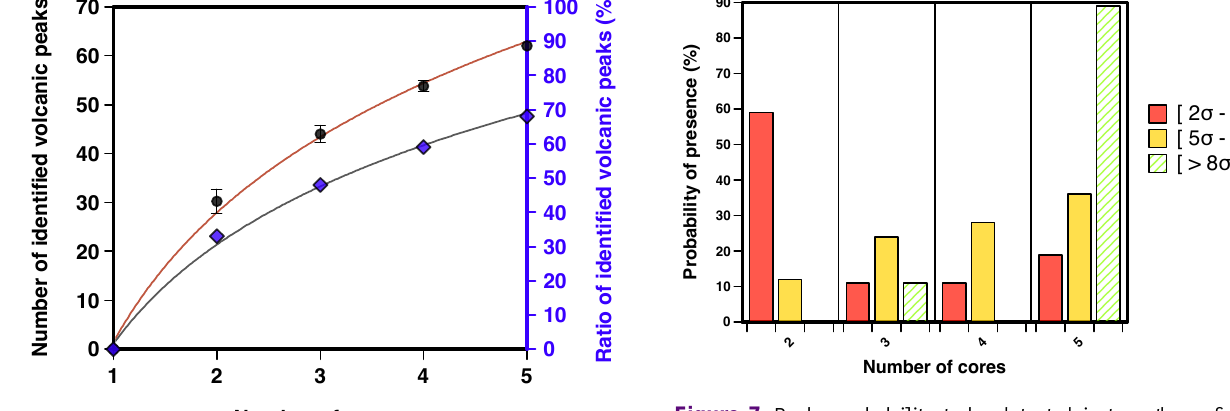
Figure 7. Peaks probability to be detected in two, three, four or five cores, as a function of their flux. The three categories of fluxes are defined by peak flux value, relatively to the average background flux, and quantified by x time (2, 5 and 8) the flux standard devia- tion (calculated for a 30ppb standard deviation in concentrations). At flux above background flux + 8 σ , there is a 90% chance of de- tecting the volcanic peak in each core of a population of five cores. On the other hand, at flux below background flux + 5 σ , there is a 60% probability of the volcanic peak being detected in two cores only among the five-core population. This highlights that replicate cores are particularly useful to avoid missing small to intermediate peaks in a record.